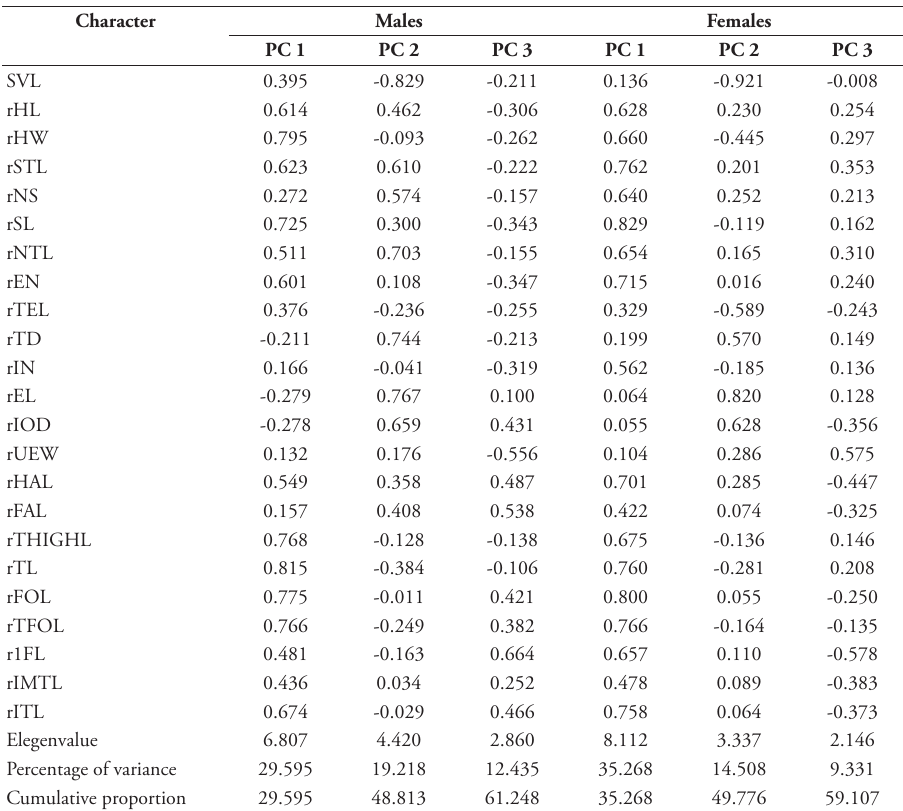
Table 3. Factor loading on the first three principal components of 23 morphological characters for male and female Fejervarya cancrivora , F. moodiei , and F. raja